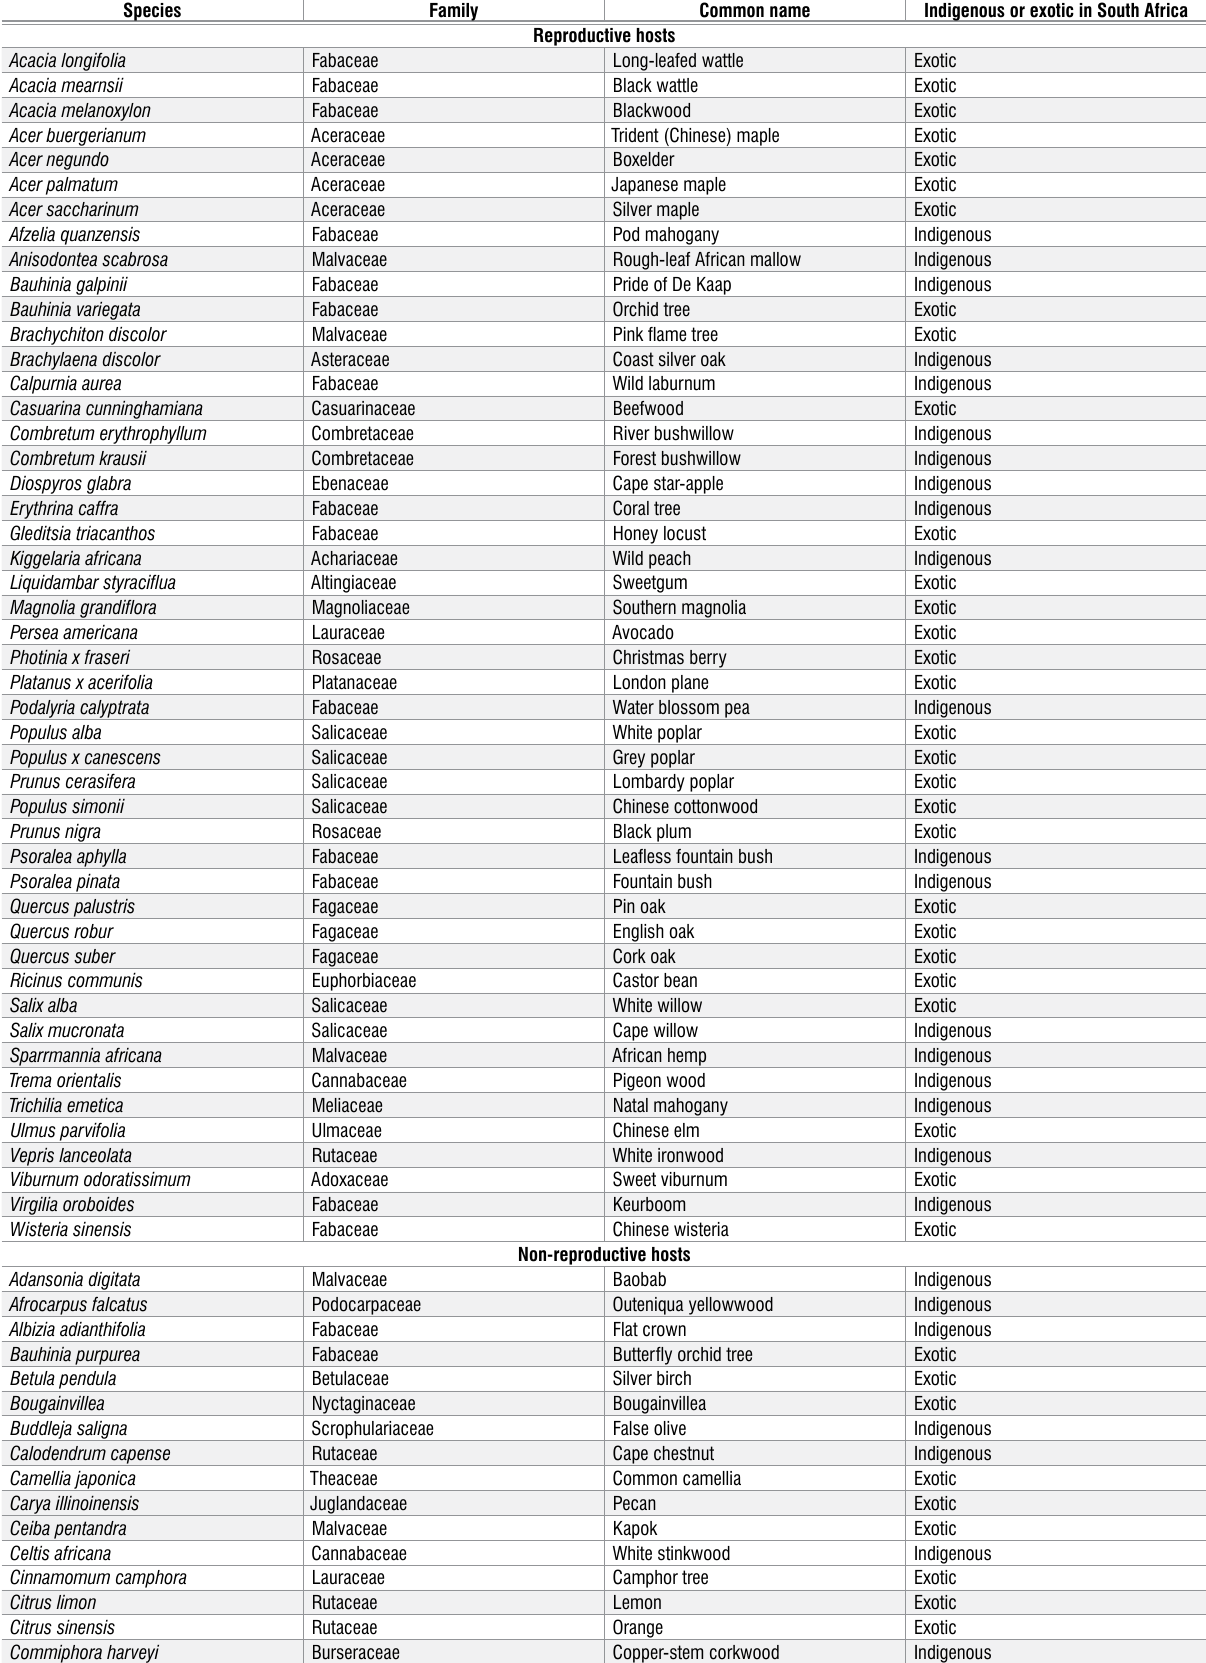
Table 1: List of confirmed host plants of the polyphagous shot hole borer beetle in South Africa. The list includes only those taxa from which its primary fungal symbiont, Fusarium euwallaceae , or a beetle individual was successfully isolated and its identity confirmed using DNA sequence fingerprinting. Reproductive hosts include only those hosts that have been shown to be suitable for PSHB reproduction at least once. Non- reproductive hosts include those from which either PSHB or F. euwallaceae was isolated, but no evidence of PSHB reproduction has been verified.